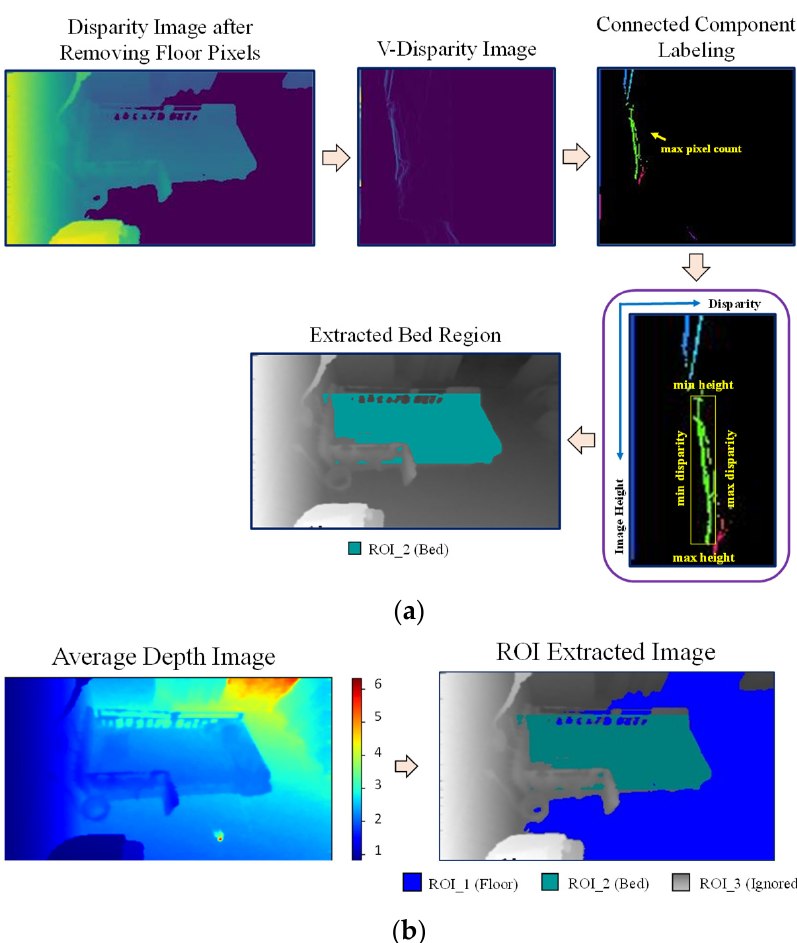
Figure 6. ( a ) Bed region extraction; ( b ) Three ROI regions.